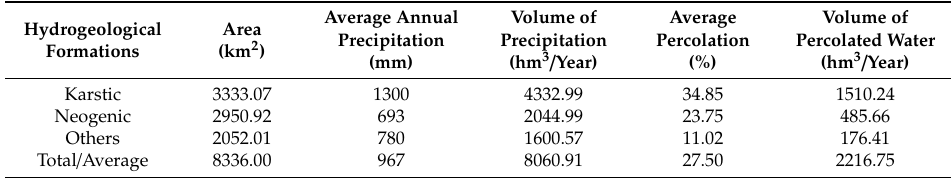
Table 8. Water potential of major hydrogeological units of Crete (table data are based on estimates of over 91 individual hydrogeological units throughout Crete). Source: